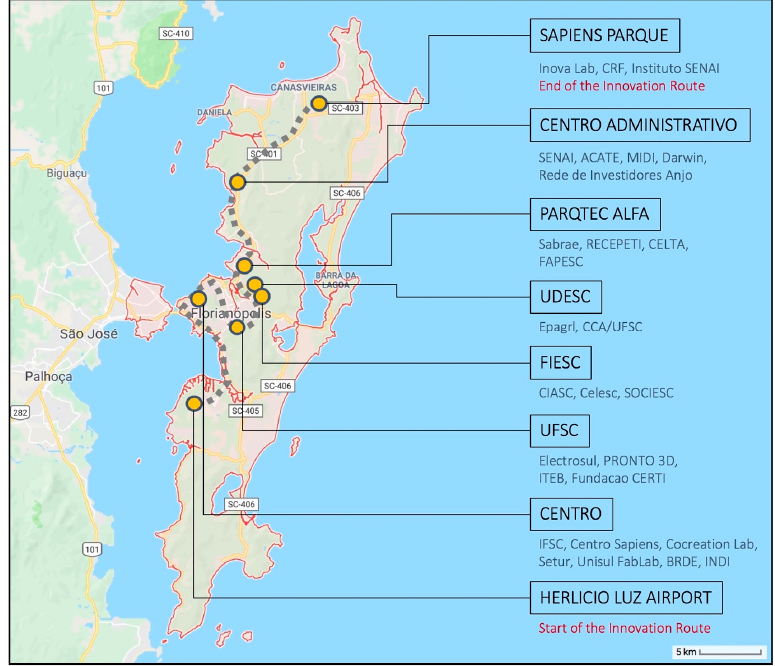
Figure 4. Location of the innovation route, drawn by authors on a Google Map base map [63]. SENAI: National Service for Industrial Training; ACATE: Association of Technology Companies in Santa